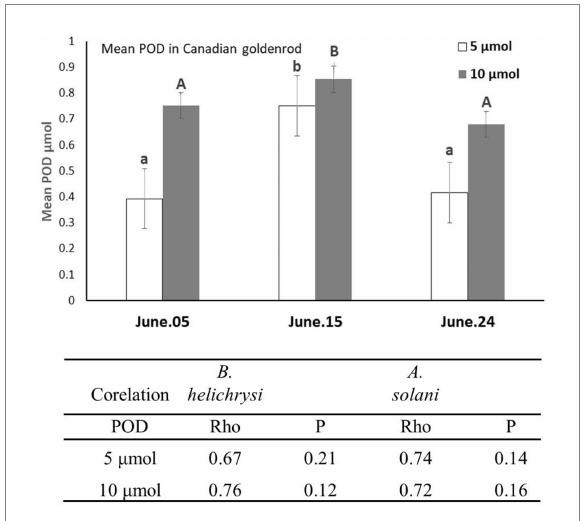
FIGURE 3 POD enzyme activity values at 5 and 10 μ mol min − 1 . mg protein − 1 unit in Canadian goldenrod. Data were compared using complete randomized factorial ANOVA of POD specific activity values. The Tukey test with p < 0.01 and LSMEAN (Minimal quadratic means) test were performed using the statistic package SAS. The average POD quantity / 20 plants / 1 m 2 sub-transect were used. Linear correlation analyses between POD activity level at both 5 and 10 μ mol min − 1 . mg protein − 1 unit and aphid species ( B. helichrysi and A solani ) abundances on Canadian goldenrod were computed for the same assessment